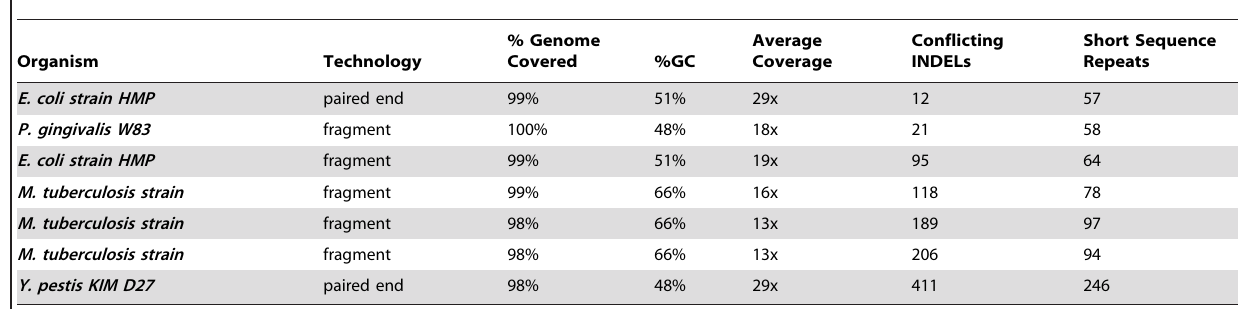
Table 4. Search for conflicting INDELs in 454-only